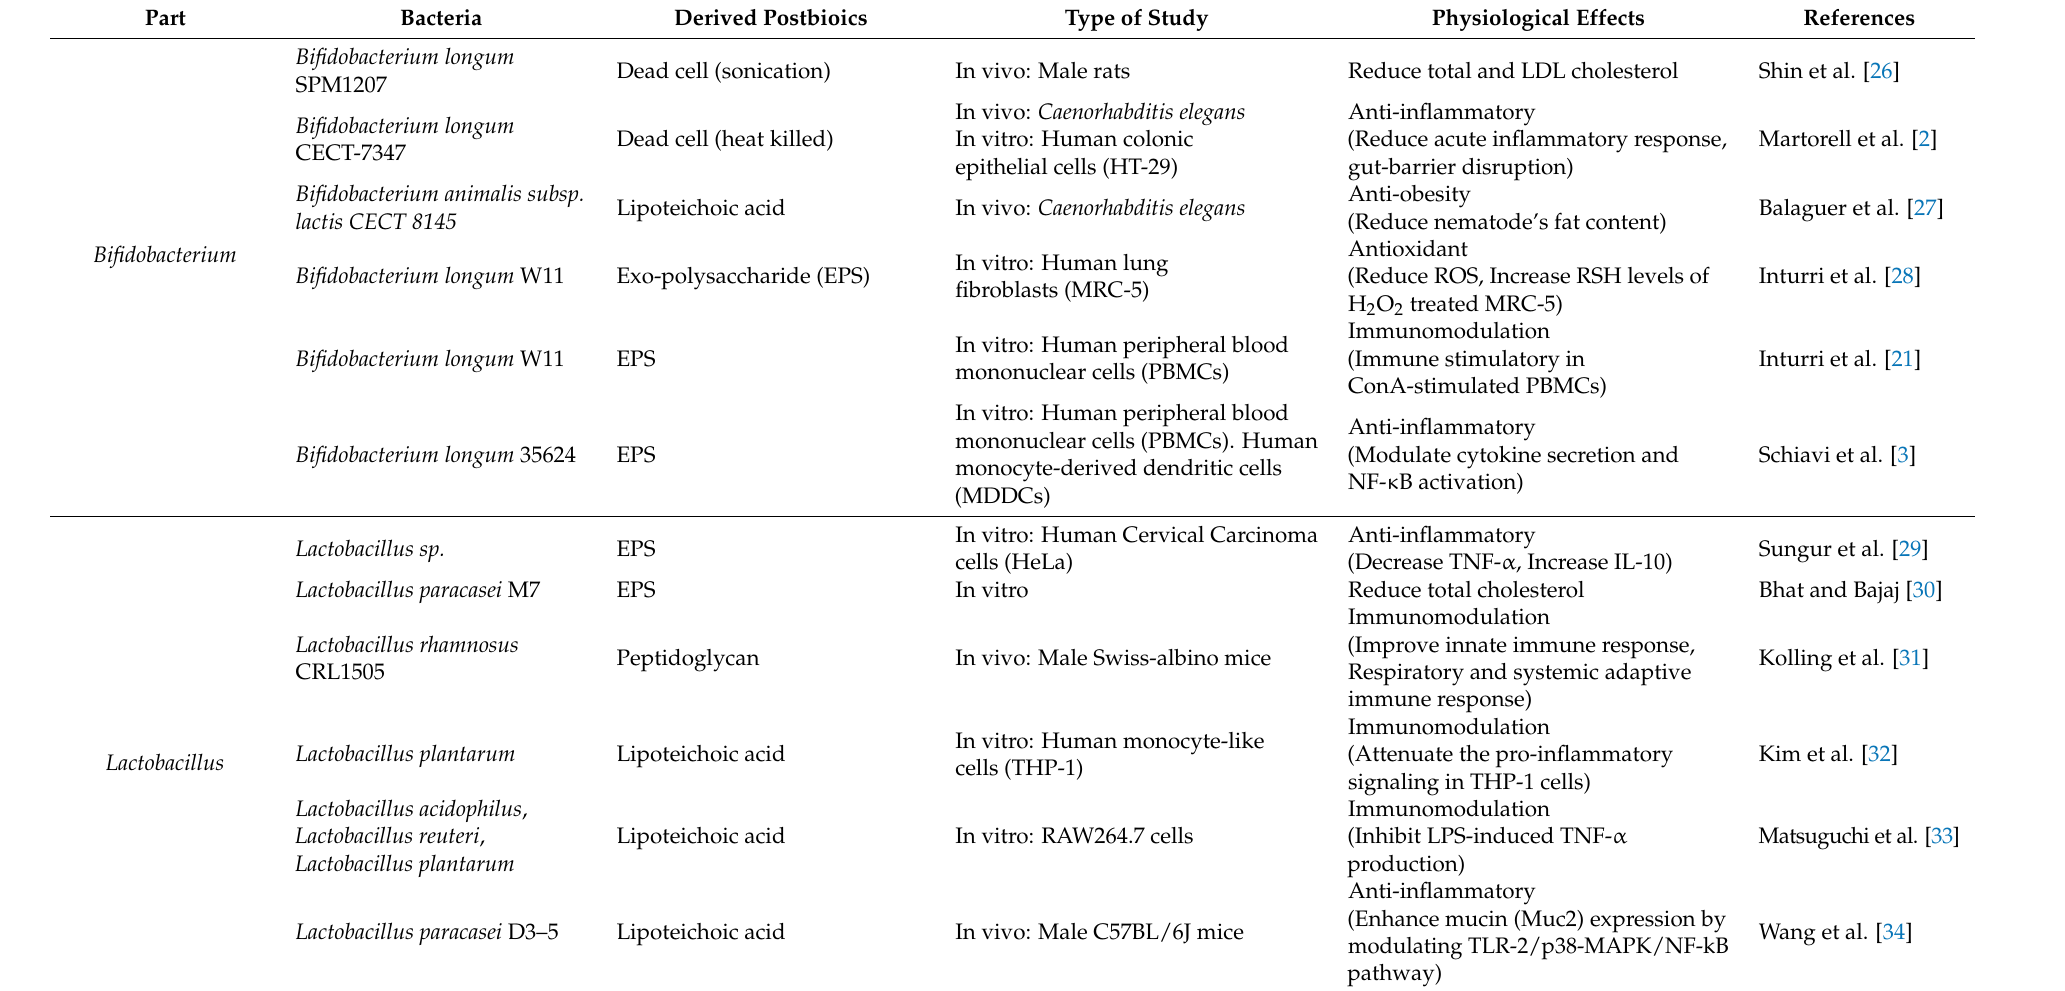
Table 1. In vitro and in vivo studies that highlight physiological effects by